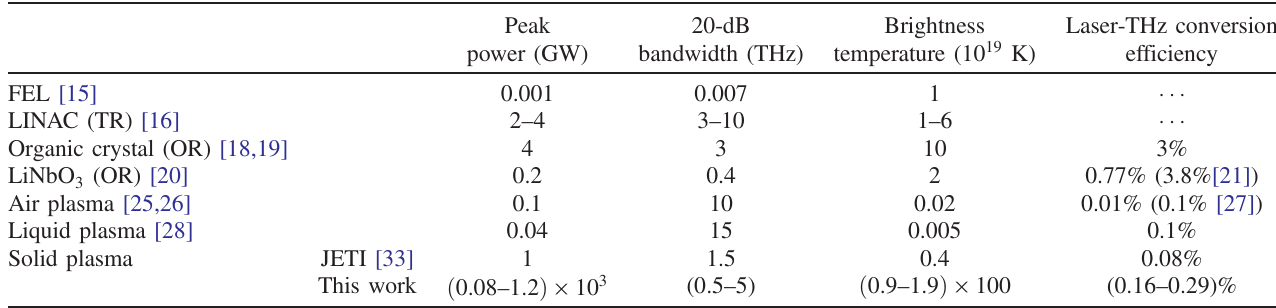
TABLE I. Comparison with state-of-the-art high-power THz sources, including a THz free-electron laser (FEL), TR in a linear accelerator (LINAC), optical rectification (OR) in organic crystals and lithium niobate (LiNbO 3 ), and laser-induced plasmas in air, liquids, and solids. All sources are broadband except the FEL. The data for existing sources are referenced from the previously reported experimental